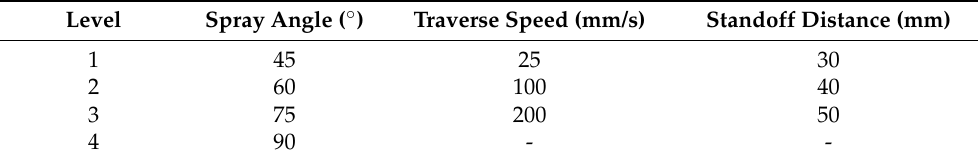
Table 1. The levels of process variables in the experimental design matrix for the preparation of single-track profiles used for the training of the proposed data-efficient neural network model.